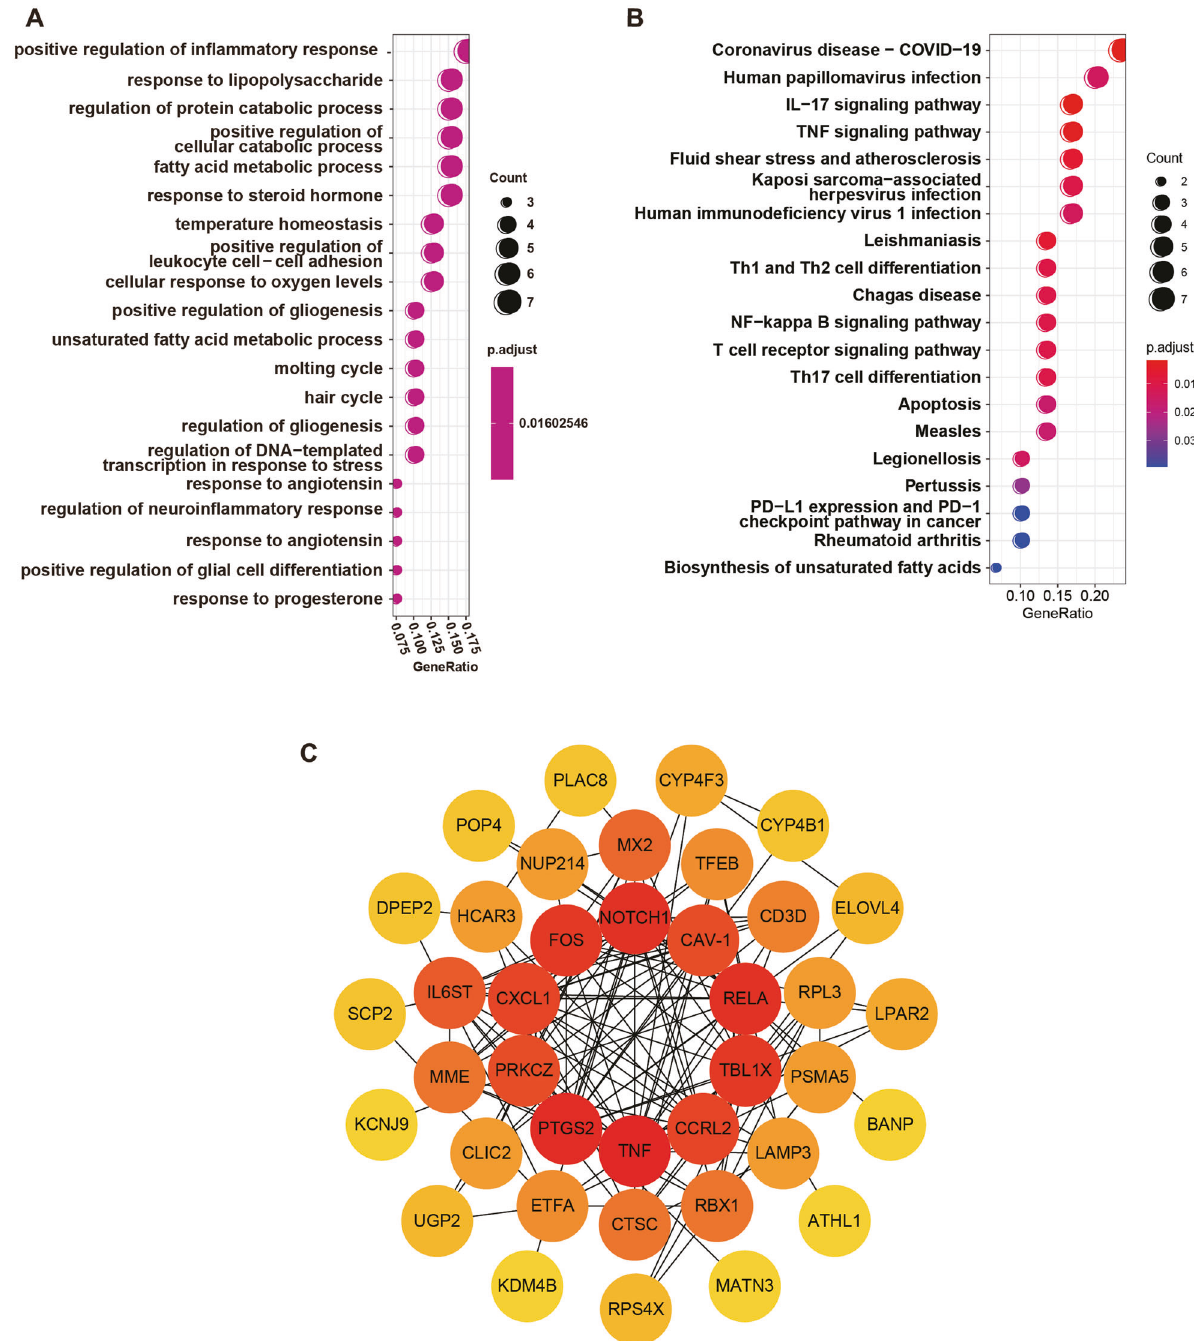
Fig. 2 Functional enrichment and PPI network construction of DEGs. A , B Bubble plots show the results of GO functional enrichment and KEGG signaling pathway enrichment of DEGs. C The PPI network of the DEGs. Nodes represent proteins, edges represent interactions between proteins, and the intensity of the color indicates the degree of interaction of each protein. Proteins with more interaction were shown in the center of the The subsequent RRA analysis found 40 robust DEGs, among which 20 genes were upregulated and the other 20 genes were downregulated (Table S3). In particular, CAV-1 and RELA expression levels were upregulated in the ALI groups (Fig. 1B, C). The functional enrichment analysis, included GO and KEGG pathways, and the most signi fi cantly enriched terms are shown in Fig. 2A, B. The 40 robust EDGs were primarily associated with the regulation of in fl ammatory response, response to lipopolysaccharide, protein